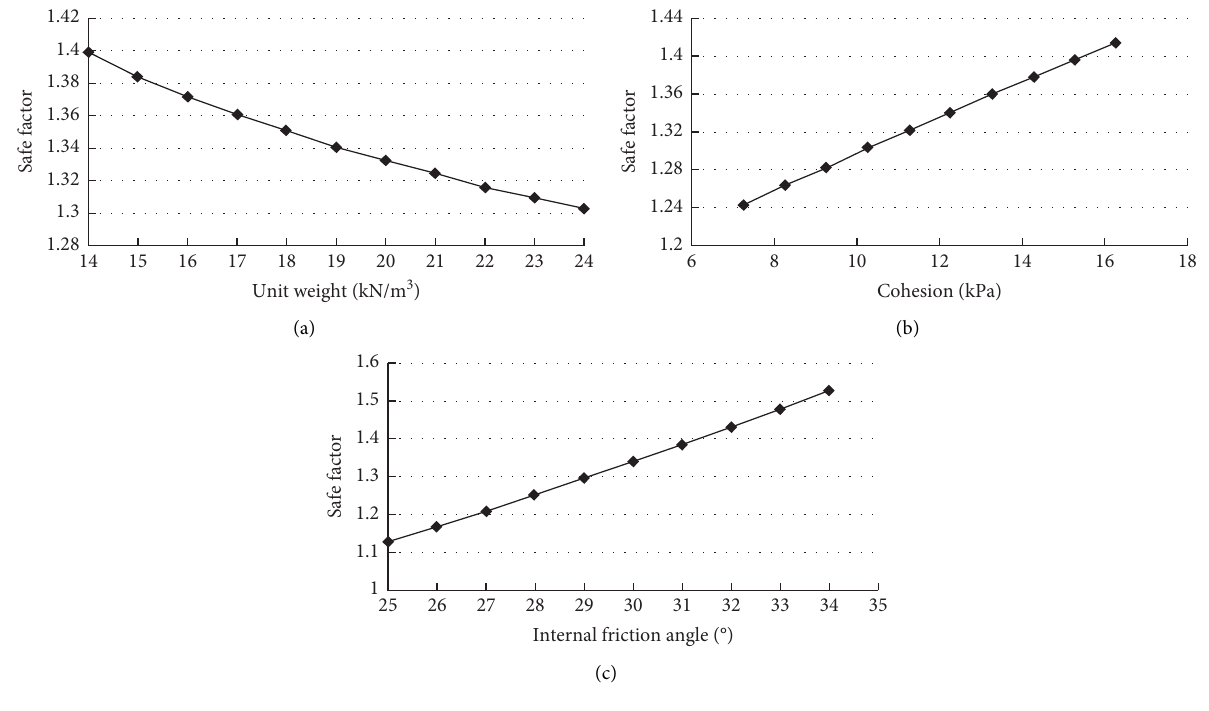
Figure 12: The diagram of the safety factor varies with the internal factors.